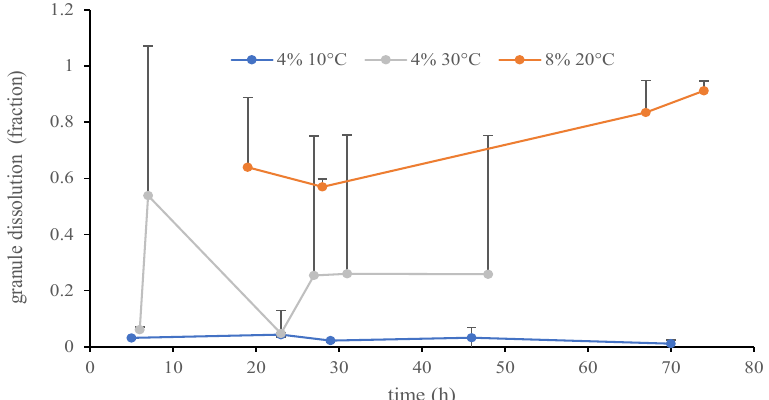
Figure 1. Urea granule dissolution rates at gravimetric soil moisture levels of 4% and 8%, and 3 temperature levels in a soil ‐ filled Petri dish incubated in a climate chamber (70% air humidity). Error bars indicate standard deviation ( n = 4).